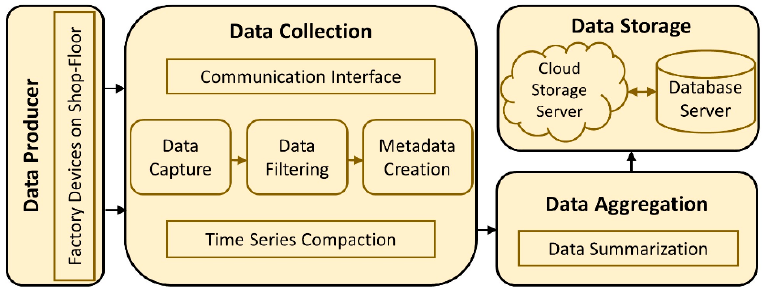
Figure 4. Data flow at data management Figure 4 . Data flow at data management component.